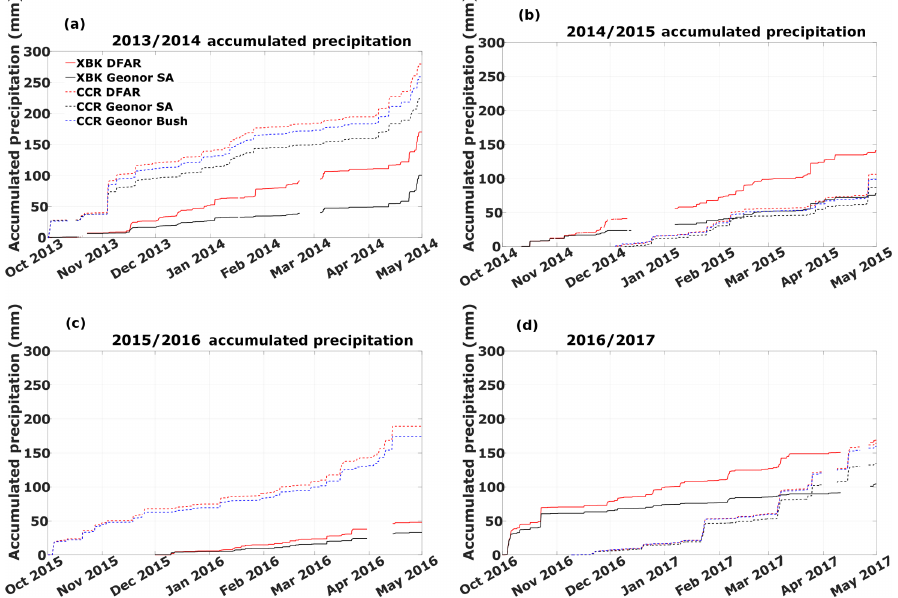
Figure 6. Seasonal time series of accumulated precipitation for the various gauge configurations at Bratt’s Lake and Caribou Creek. Note that although the accumulation season is from 1 October through 30 April, not all time series start at the beginning of the season due to gauge or site issues (see Table